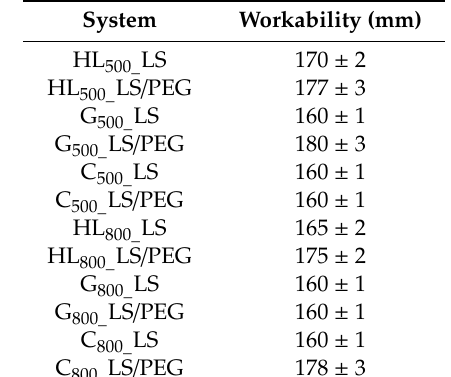
Table 2. Values of workability of the mortars possessing different compositions.